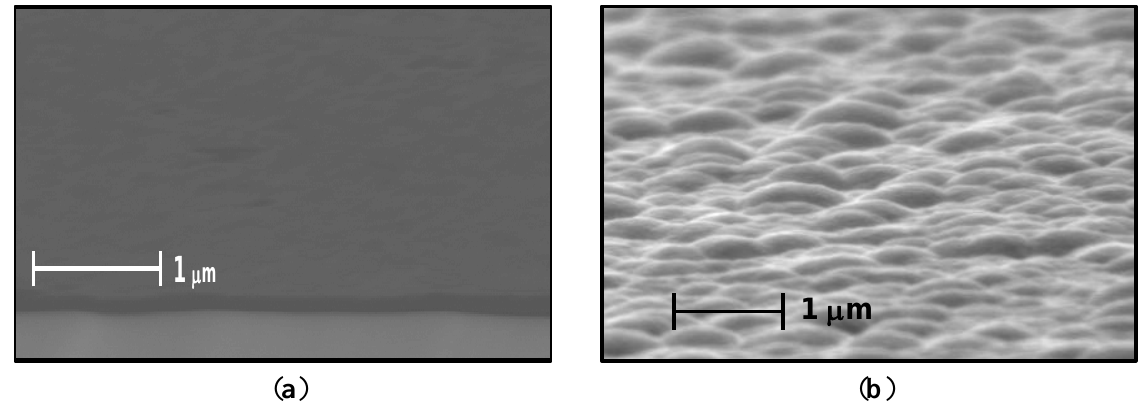
Figure 14. SEM images of the surfaces of (a) the planar structure with an AR coating and 1 period DBR at the back; the image shows a bit of the edge of the sample and the top surface, which reveals how planar the surface is, and (b) the structure with an AR coating, 1 period DBR and an aluminum layer. The roughness in the aluminum is carried through to the entire structure and hence the bumpy